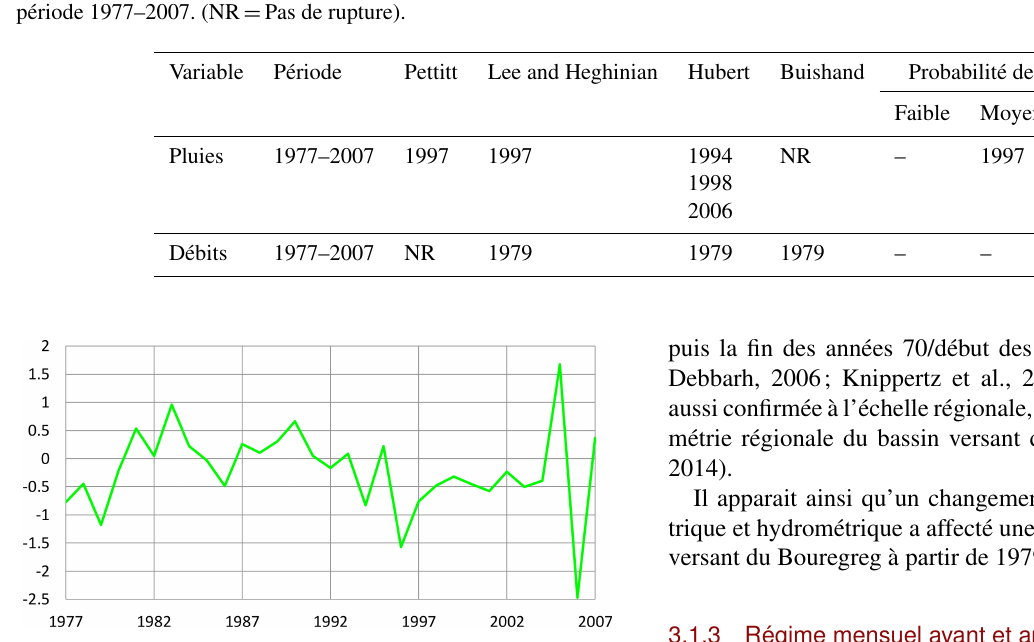
Figure 3. Différence indice pluviométrique moins indice hydromé-